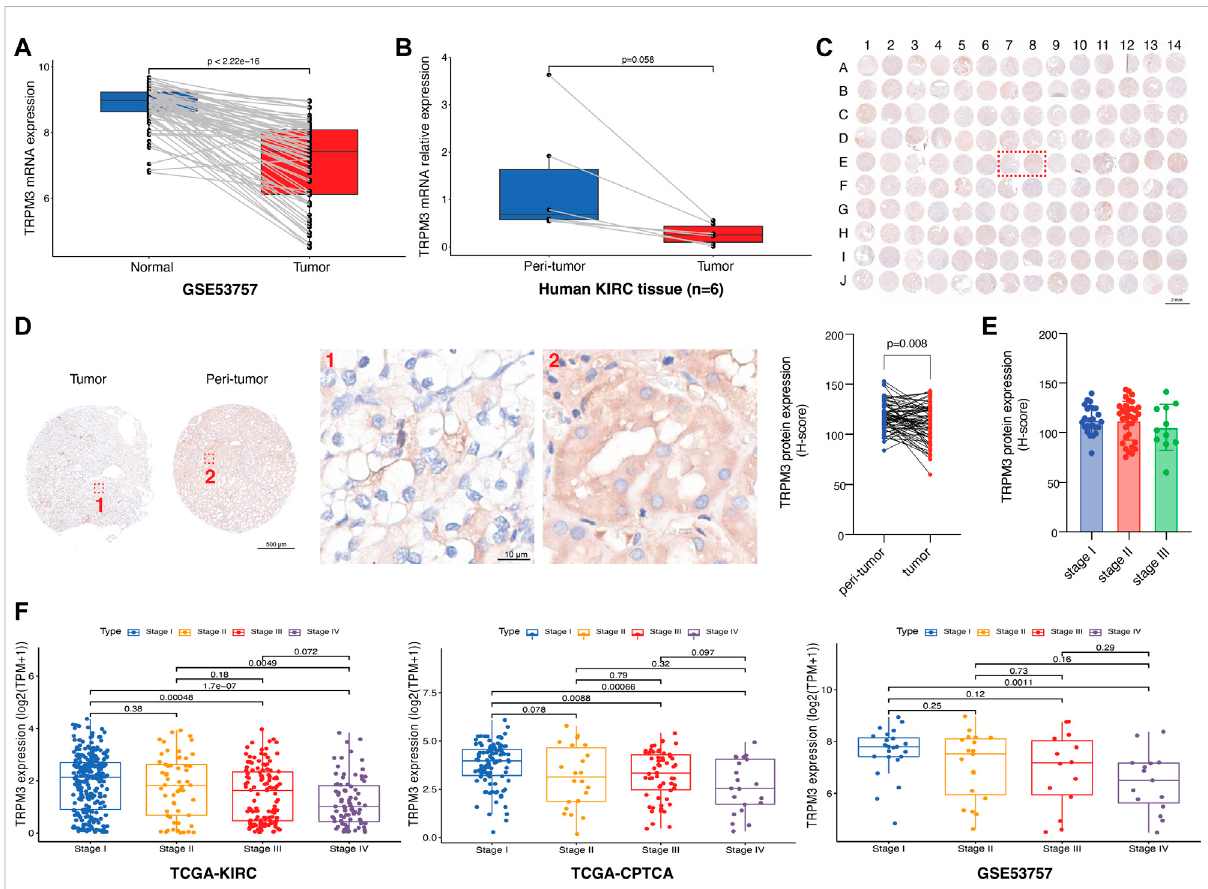
FIGURE 9 Validation of TRPM3 in KIRC. (A) TRPM3 mRNA expression between paired tissues in GSE53757 cohort ( n = 72). (B) TRPM3 mRNA expression betweenhumanKIRCpairedtissues( n =6). (C) Tumormicroarrayof70KIRCpairedtissuesstainedforTRPM3protein. (D) TRPM3proteinexpression between paired tissues in tissue microarray [Representative images are the ones inside the red wireframe in (C) ]. (E) TRPM3 protein expression between different KIRC stages. (F) TRPM3 mRNA expression between different KIRC stages in TCGA-KIRC, TCGA-CPTAC, and GSE53757